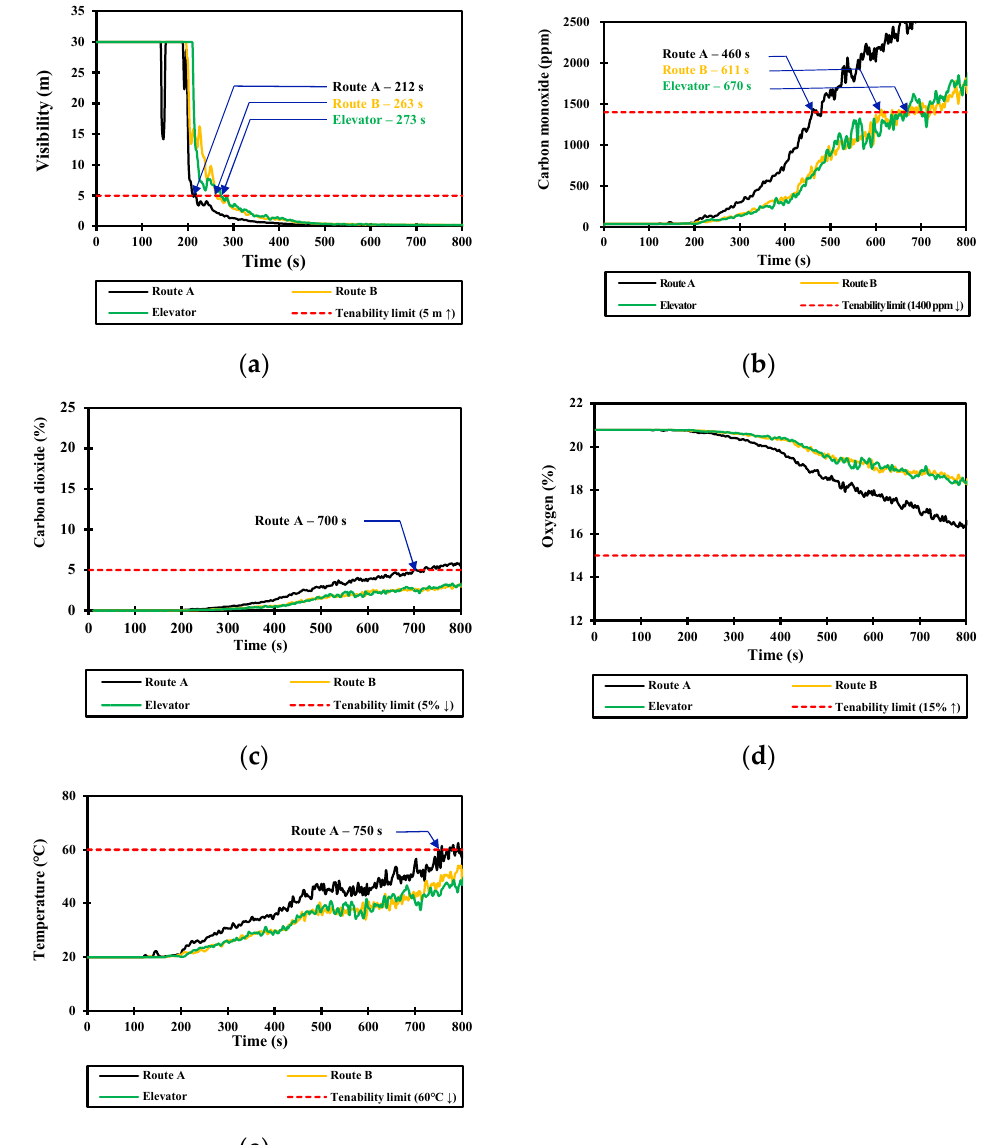
Figure 5. ( a ) Visibility; ( b ) carbon monoxide; ( c ) carbon dioxide; ( d ) oxygen; ( e ) temperature.